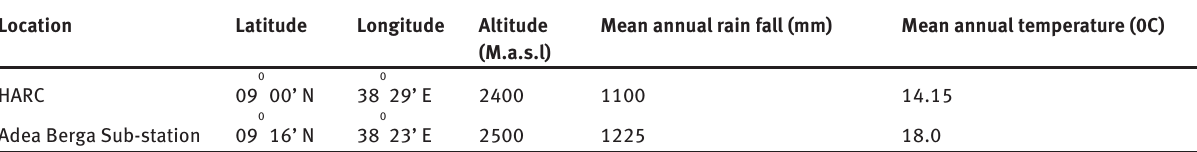
Table 1: Description of the study areas